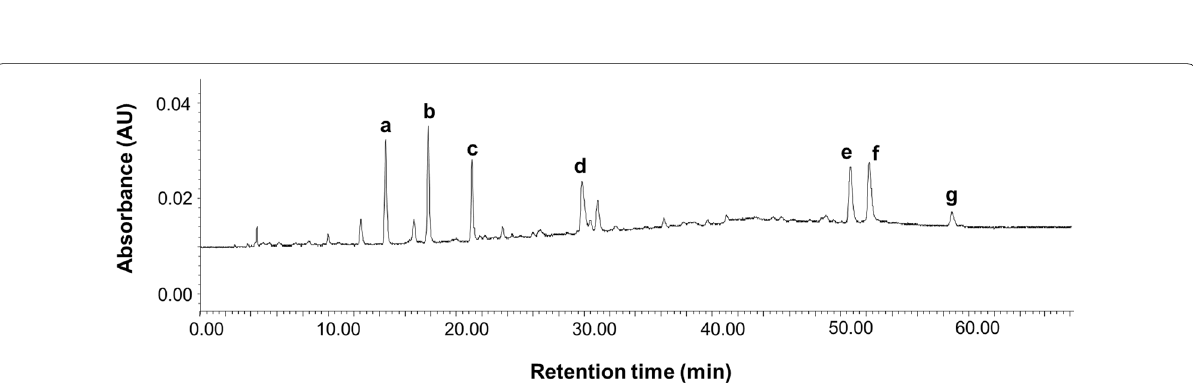
Fig. 4 HPLC chromatogram of PMM for chemical profile. Established chemical profile method: Capcellpak AQ C18 column (4.6 at 40 °C, wavelength 254 nm, injection volume 20 μl. Mobile phase 0.02% (v/v) trifluoroacetic acid in water (A) and 0.2% (v/v) trifluoroacetic acid in 50% acetonitrile (B), flow rate 1 ml/min. The gradient elution 0–10 min, 0%–5% B; 10–65 min, 5%–50%